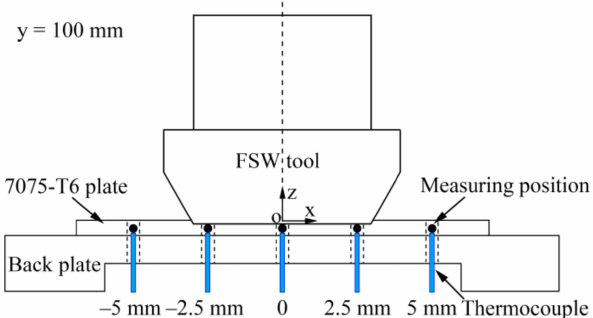
Figure 4. Schematic of temperature